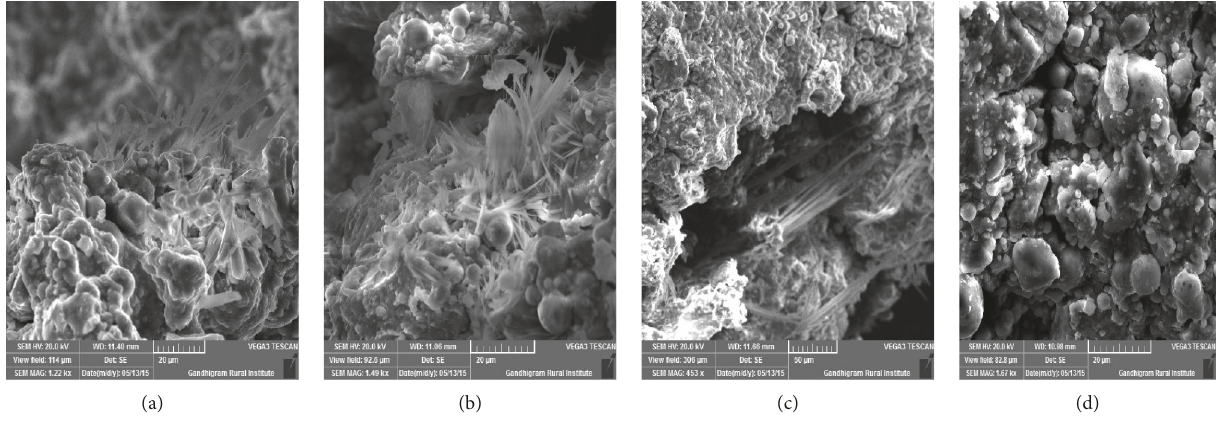
Figure 8: SEM images of (a) GPB 25 , (b) GPF 25 , (c) GPG 25 , and (d) GPGn 25 . Table 2: Significance relation between sand, soil, and admixture.